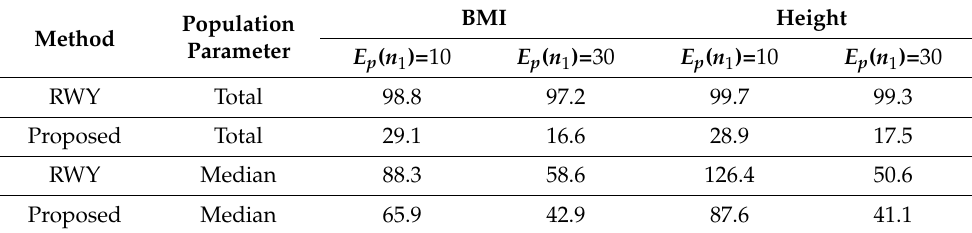
Table 5. The percent relative root mean square errors of the bootstrap variance